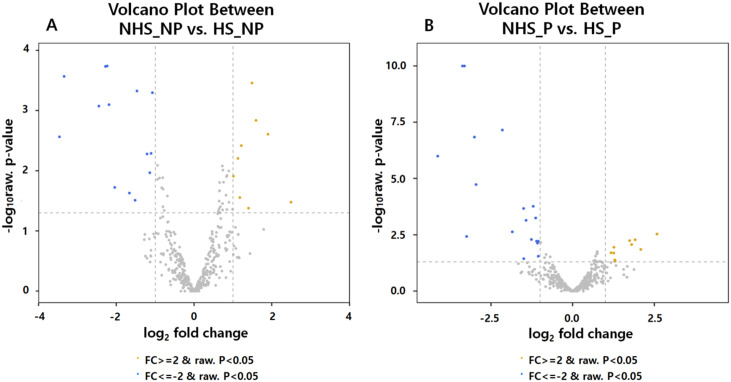
Volcano plot showing differentially expressed miRNAs between NHS and HS using transformed normalized data.|Fold change| value ≥ 2 and P < 0.05 are represented different colors (minus: blue, plus: yellow). (A) Differentially expressed miRNA values in non-pregnant cows; (B) Differentially expressed miRNA values in pregnant cows; HS, Heat stress; NHS, Non-heat stress; P, Pregnancy; NP, Non-pregnancy.